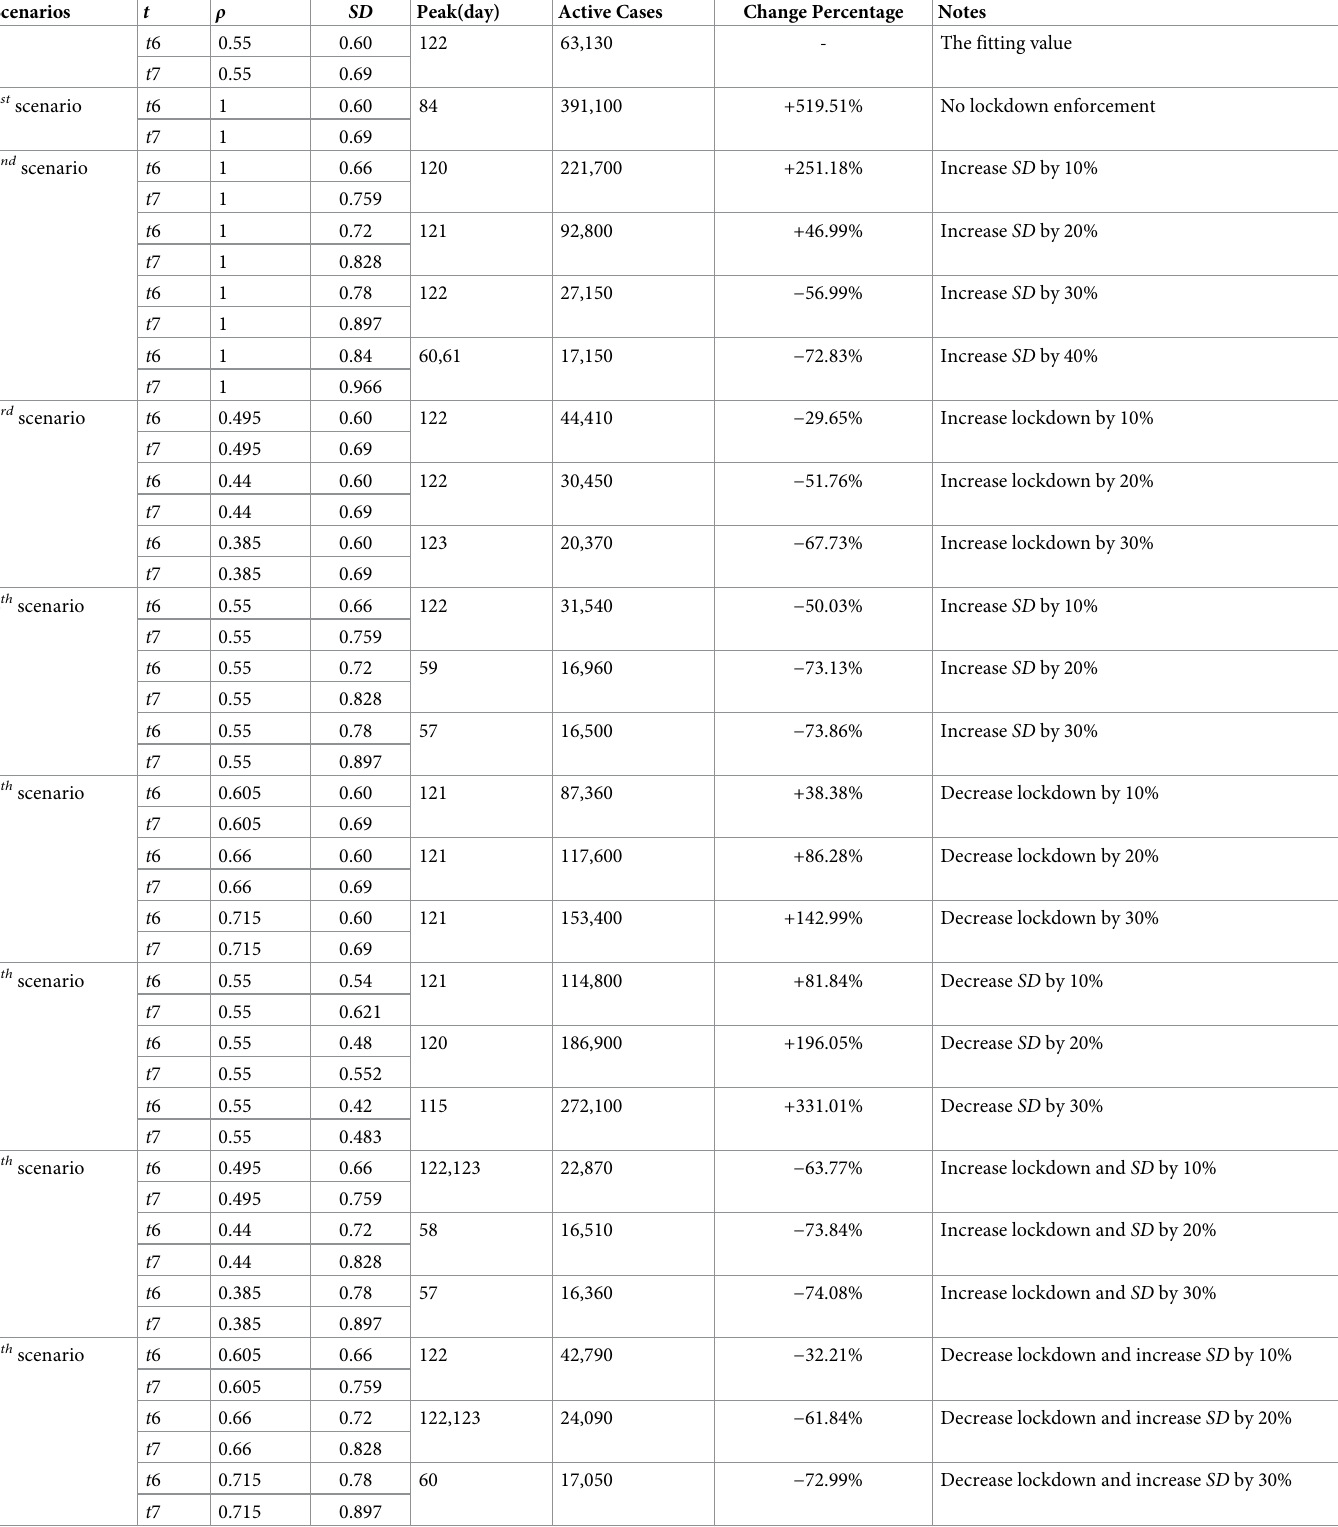
Table 8. Results of different scenarios for Phase